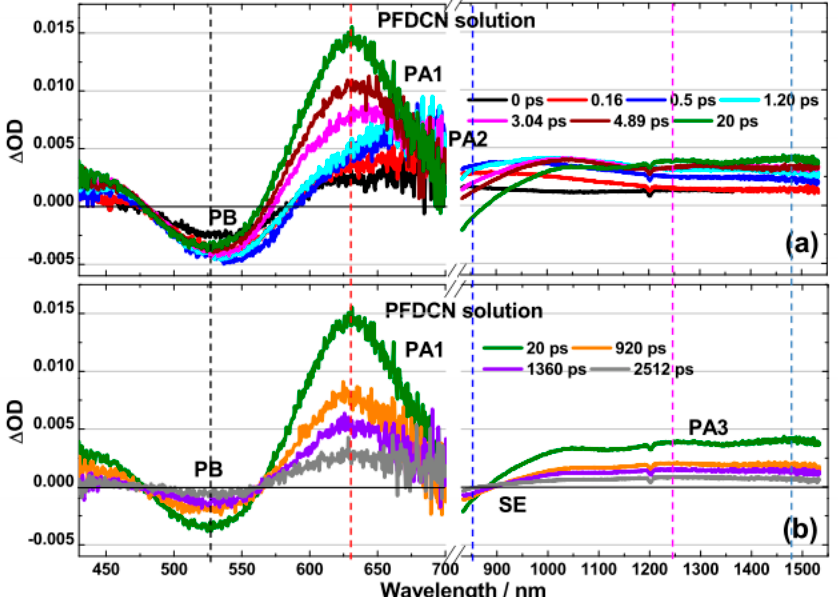
Figure 2. Transient absorption spectra of PFDCN in chlorobenzene solution with excitation wavelength at 400 nm (6.30 × 10 13 photons·cm − 2 ·pulse − 1 ). ( a ) Spectra at first 20 ps and ( b ) spectra at 20 ps–2512 ps in visible and NIR region. The break (/ /) from 700 nm to 830 nm, where be interference by laser at 800 nm.